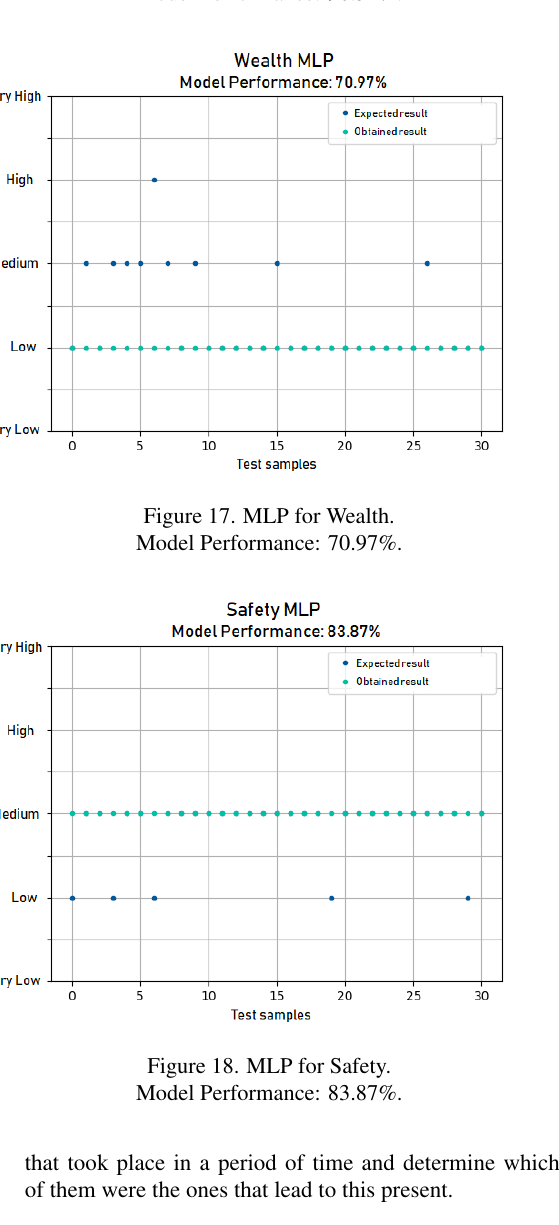
Figure 16. MLP for Fun. Model Performance: 90.32%.